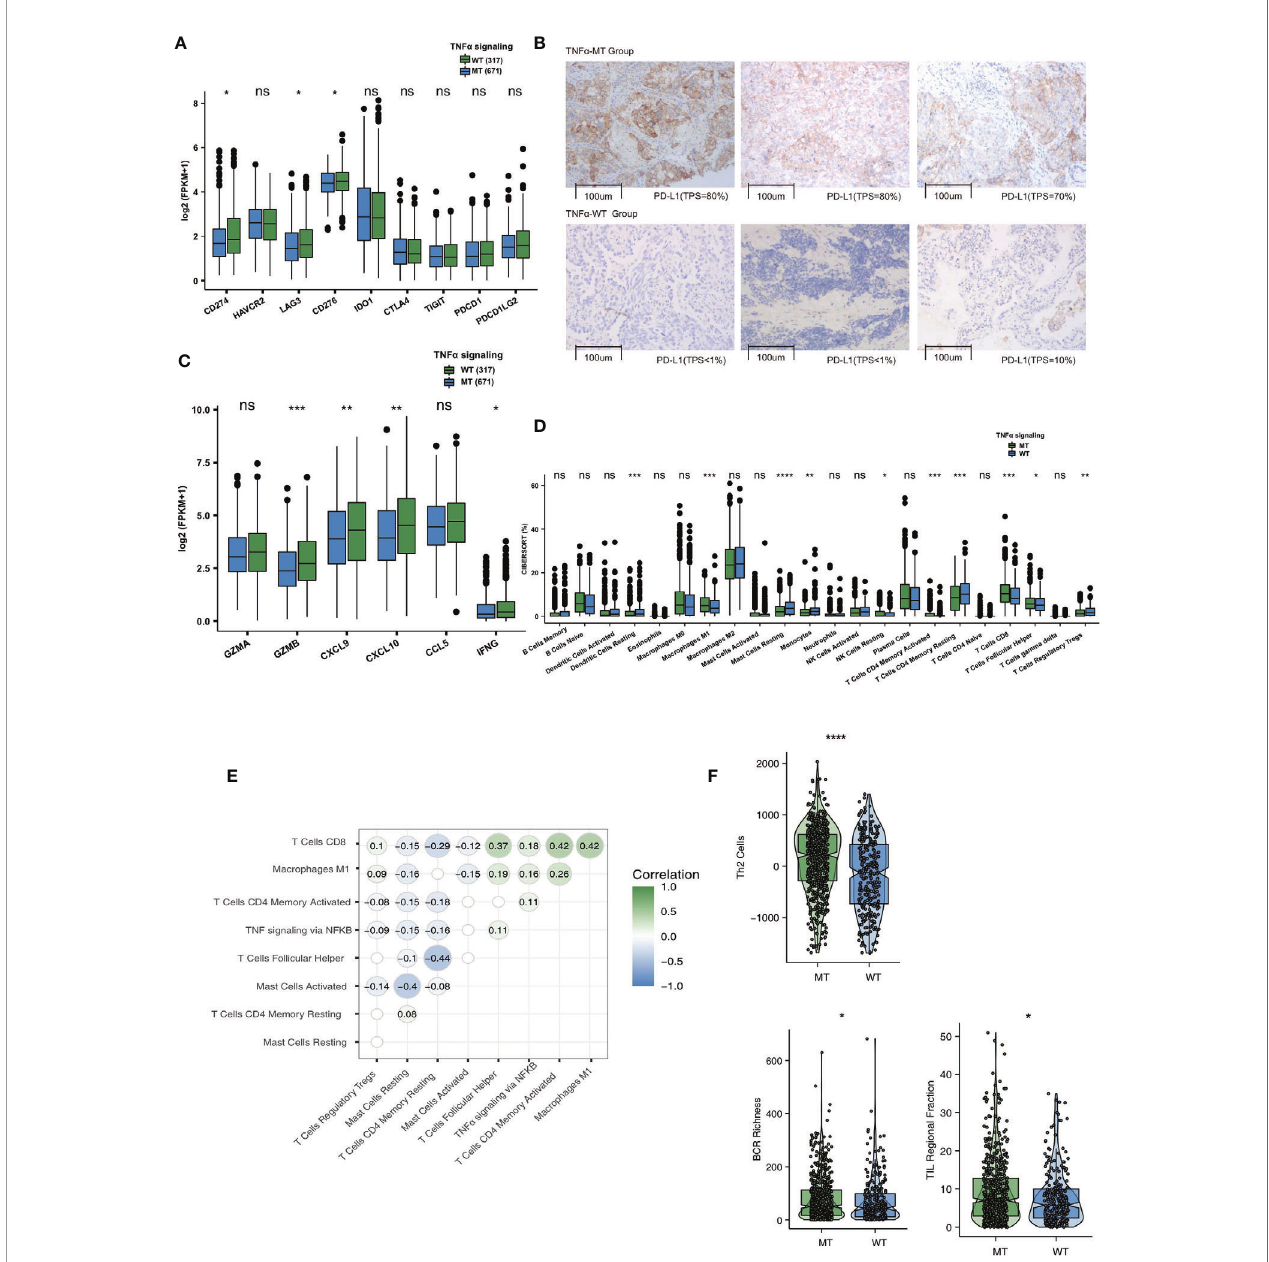
FIGURE 4 | TNF a -MT NSCLC was associated with a signi fi cant enrichment of immune cells and enhanced immune scores. (A) Comparison of the expression of immune checkpoints between TNF a -MT and TNF a -WT tumors in the TCGA-NSCLC cohort. (B) The typical cases for each TPS level between the TNF a -MT (3 samples) and TNF a -WT (3 samples) groups in the Local-NSCLC. (C) Comparison of the expression of immune-related genes between TNF a -MT and TNF a -WT tumors in the TCGA-NSCLC cohort. (D) Comparison of immune cells between TNF a -MT and TNF a -WT tumors in the TCGA-NSCLC cohort. (E) Correlation analysis between the proportions of several immune cell types and number of TNF a signaling mutations. (F) Comparison of immune scores between TNF a -MT and TNF a - WT tumors in the TCGA-NSCLC cohort. (*P < 0.05; **P < 0.01; ***P < 0.001; and ****P < 0.0001; Wilcoxon rank-sum test). NSCLC, non small-cell lung cancer; TCGA, The Cancer Genome Atlas; TPS, Tumor Proportion Score. ns, not signi fi